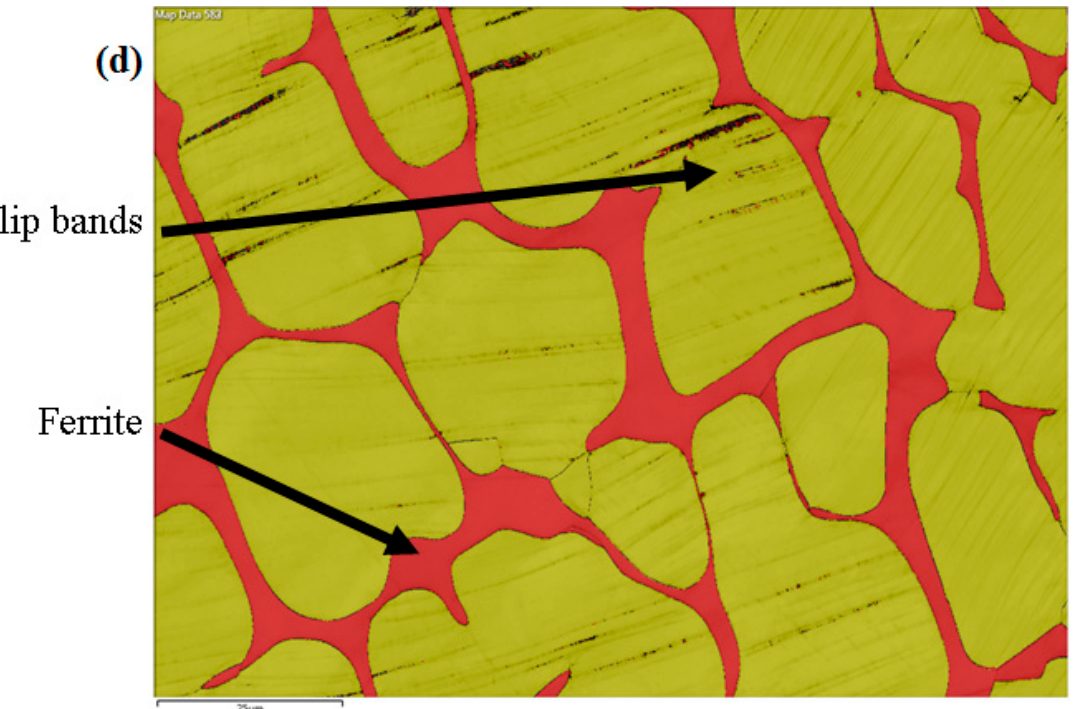
Figure 9. EBSD of 10% deformation, ( a ) LF 10% 200×; ( b ) LF 10% 1000×; ( c ) HF 10% 200×; ( d ) HF 10% 1000×.